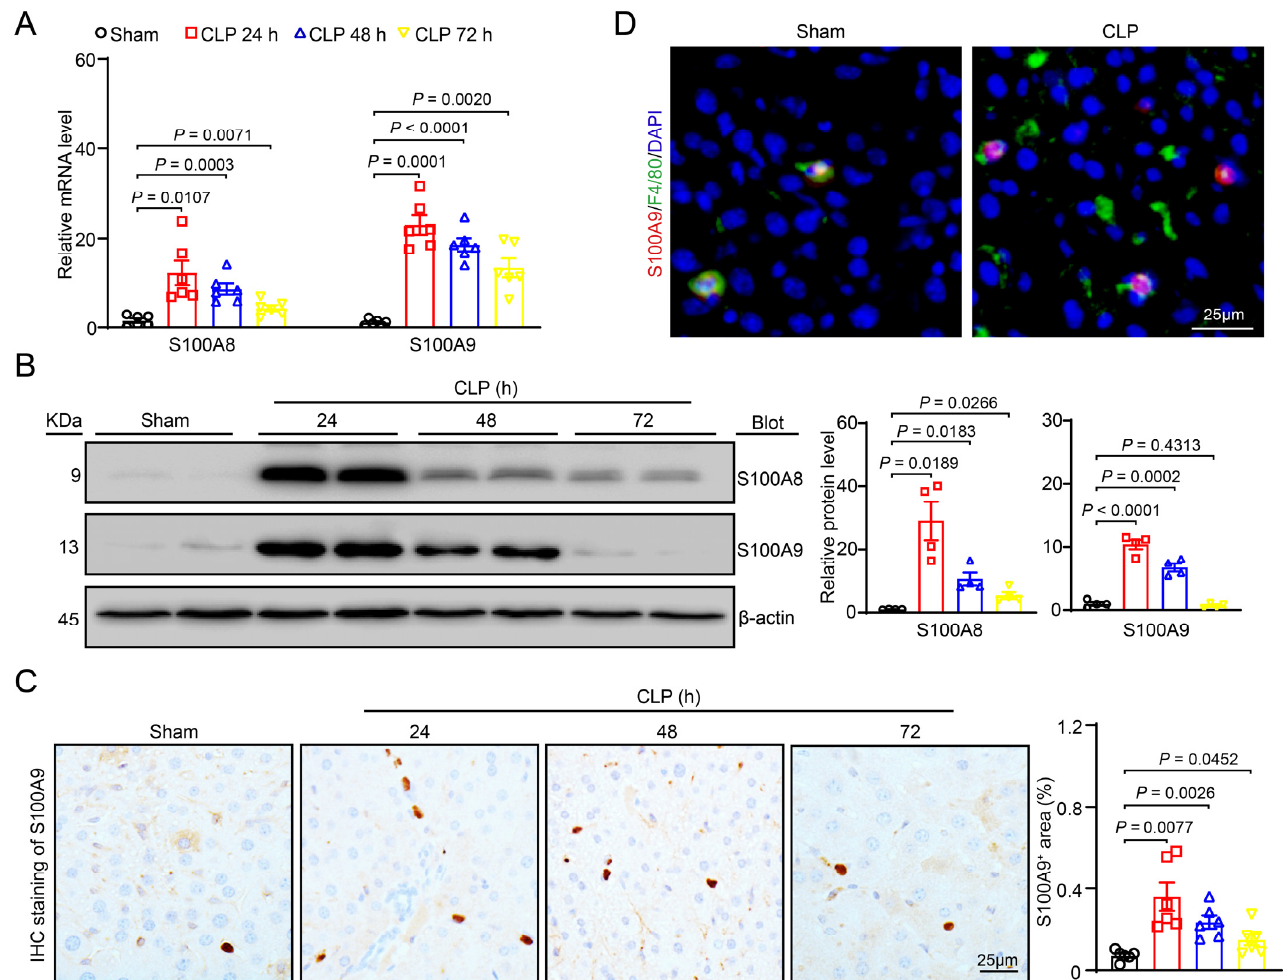
Figure 1. Upregulation of S100A8/A9 in the liver of CLP-treated mice. Polymicrobial sepsis in wild-type (WT) mice was induced by cecal ligation and puncture (CLP) for 24–72 h. Sham group: 24 h. ( A ) qPCR assay of S100A8 and S100A9 mRNA levels in the liver at each time point ( n = 6). ( B ) Immunoblotting analysis of S100A8 and S100A9 protein levels in the liver at each time point (left), and quantification of the relative protein level (right, n = 4). ( C ) Immunohistochemical staining of liver sections with anti-S100A9 antibody (left, brown area), and quantification of the S100A9 + area (right, n = 6). ( D ) Immunofluorescent staining of liver sections with anti-F4/80 (green) or anti-S100A9 (red) antibody to examine localization of S100A9 in F4/80 + macrophages. Data are shown as mean ± SEM, and n represents the number of mice in each group.